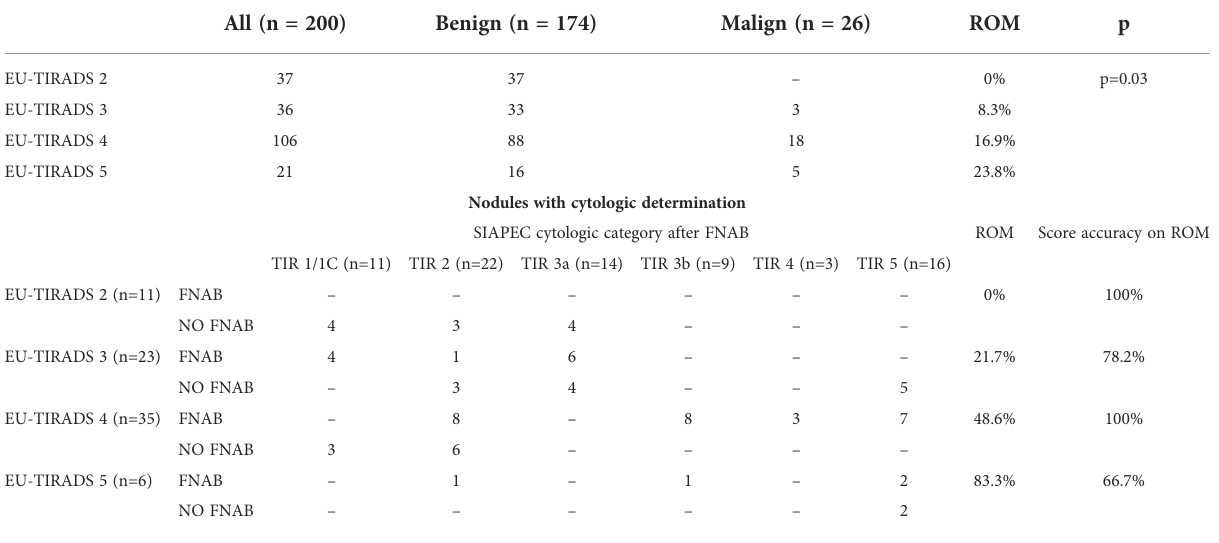
TABLE 3 Correlation between cytological categories and EU-TIRADS score. All nodules